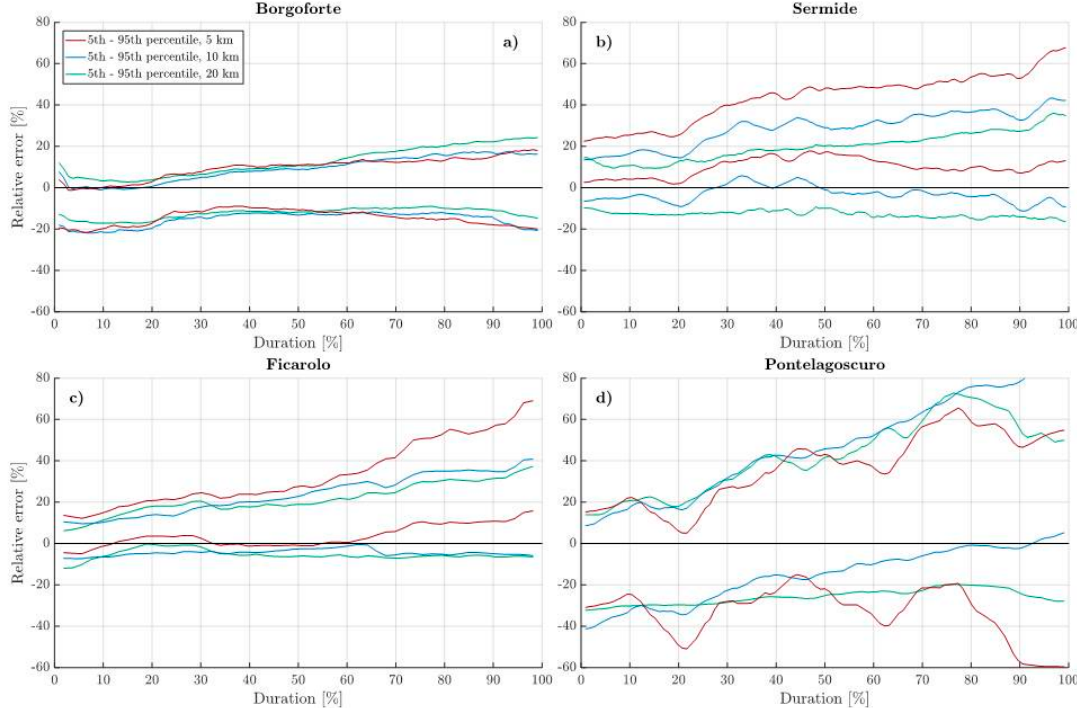
Figure 10. The 90% confidence intervals of the errors between FDCs obtained with synthetic true data (black dashed line in Figure 9) and those based on SWOT data at different duration and adopting different river discretizations.